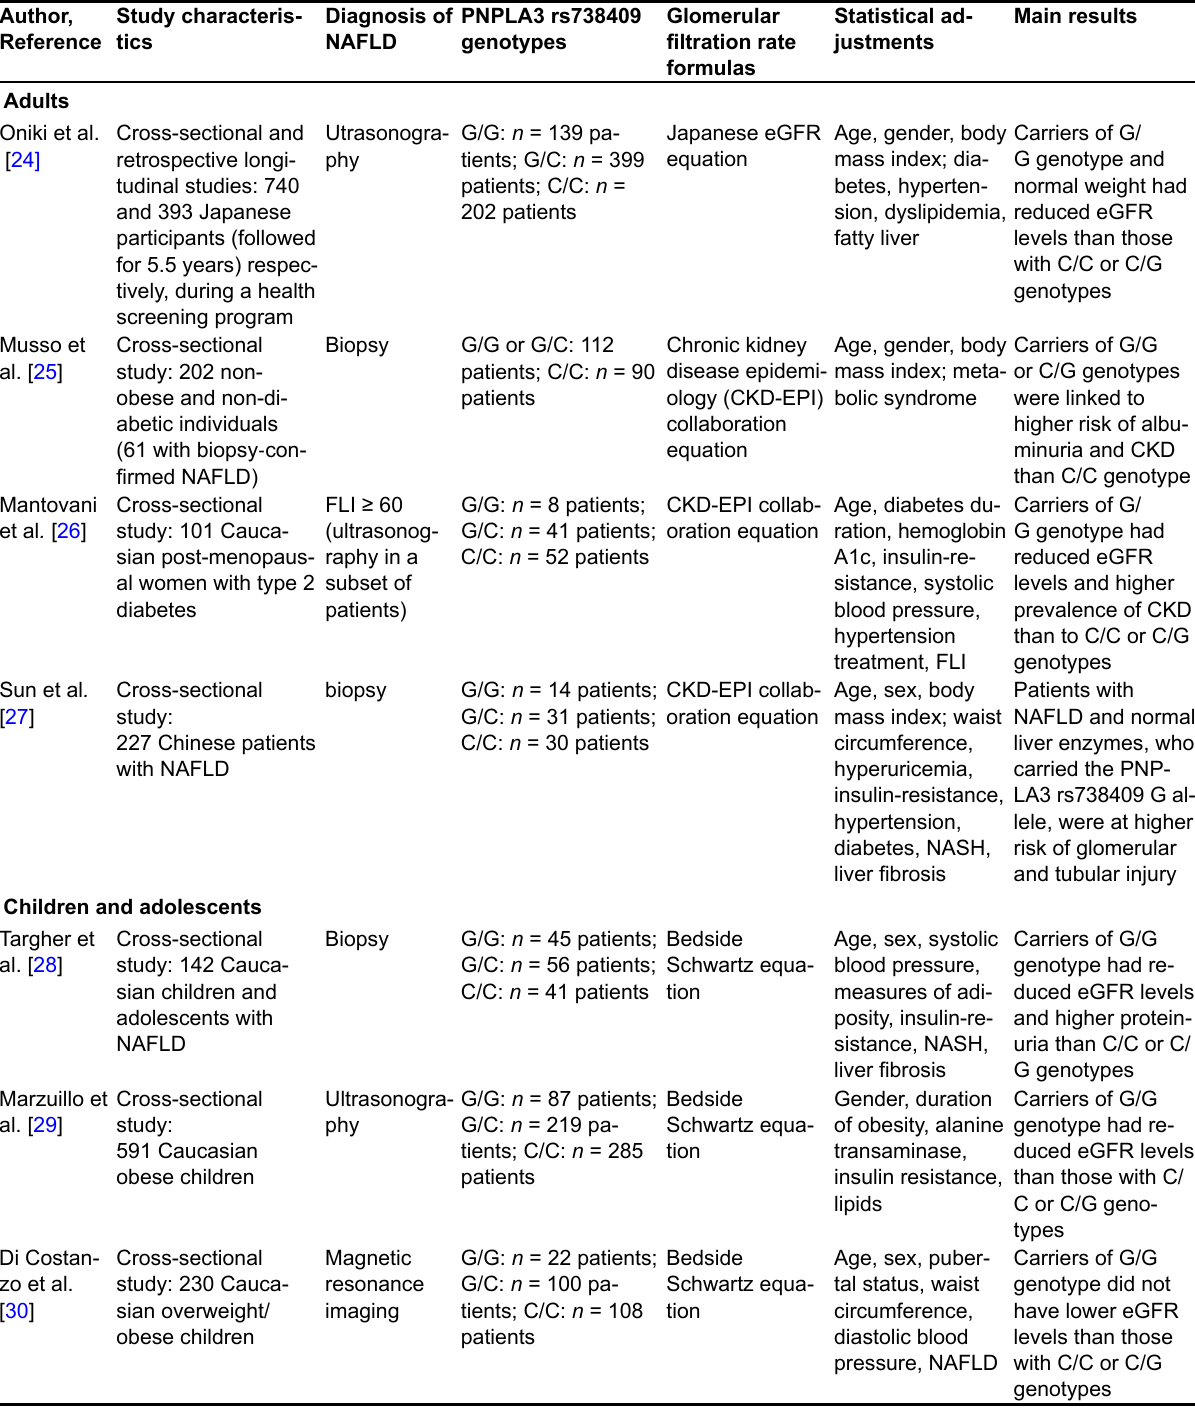
Table 1. Observational studies on the relationship between patatin-like phospholipase domain-containing protein-3 rs738409 genotype and kidney function (ordered by publication year and study population)